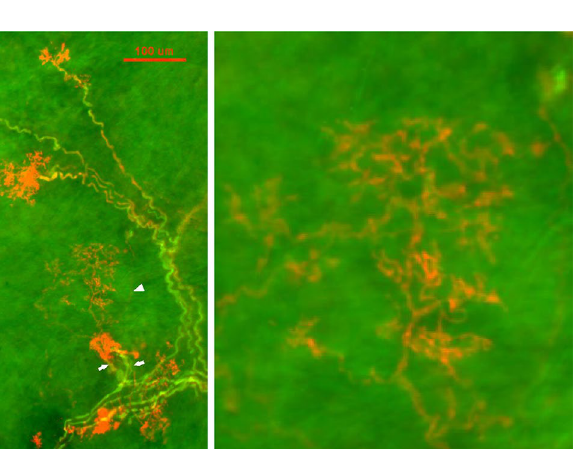
Figure 3. A double staining approach (Na + /K + -ATPase and MBP) to identify baroreceptor structures. Two types of can be identified: (1) solid, compacted, and ball-like structures (four arrows in upper figure denote each); (2) a much larger, extended diffuse-type structure (denoted by arrows in the upper middle of the figure). Clearly, they differ morphologically. The intensity of the staining is much higher in the former; however, both are connected to myelinated afferents (green axons), which is denoted by an arrowhead for the diffuse-type. The diffuse structure is much more easily observable in the black and white figure (bottom), in which 2 arrows denote 2 other smaller diffuse structures. The scale bar is 100 µm.